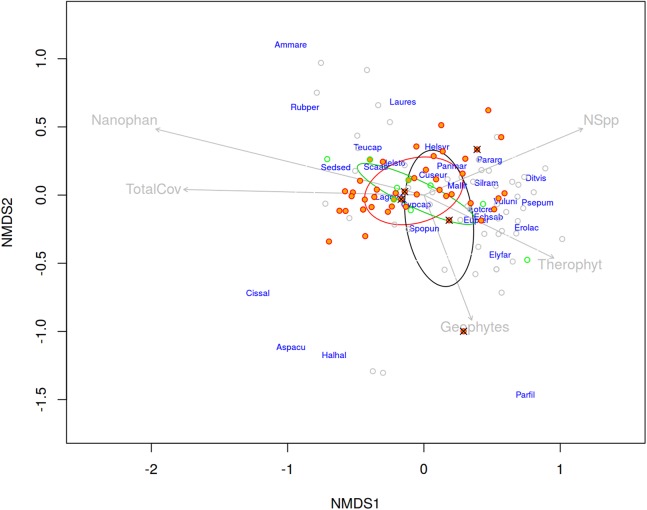
Non-metric multidimensional scaling (NMDS) for accompanying species represented by pairwise Bray–Curtis distances between individuals (stress = 0.1413).Orange filled points represent quadrats with the presence of diploid C. aspera, green with allotetraploid C. seridis, crosses with triploid hybrids, and empty circles quadrats with absence of Centaurea. Ellipses represent standard deviations for the three species. Arrows are fitted environmental variables. Analysis was performed in “El Saler North” site. Nanophan, nanophanerophytes; Theroph, therophytes; TotalCov, Total cover; Nspp, Number of species; Ammare, Ammophila arenaria; Rubper, Rubia peregrina; Laures, Launaea resedifolia; Teucap, Teucrium capitatum; Helsyr, Helianthemum syriacum; Sedsed, Sedum sediforme; Scaatr, Scabiosa atropurpurea; Panmar, Pancratium maritimum; Pararg, Paronychia argentea; Cuseur, Cuscuta europaea; Mallit, Malcolmia littoralis; Silram, Silene ramosissima; Ditvis, Dittrichia viscosa; Lagova, Lagurus ovatus; Cypcap, Cyperus capitatus; Vuluni, Vulpia unilateralis; Psepum, Pseudorlaya pumila; Lotcre, Lotus creticus; Echsab, Echium sabulicola; Spopun, Sporobolus pungens; Erolac, Erodium laciniatum; Elyfar, Elymus farctus; Cissal, Cistus salvifolius; Aspacu, Asparagus acutifolius; Halhal, Halimium halimifolium; Parfil, Parapholis filiformis.